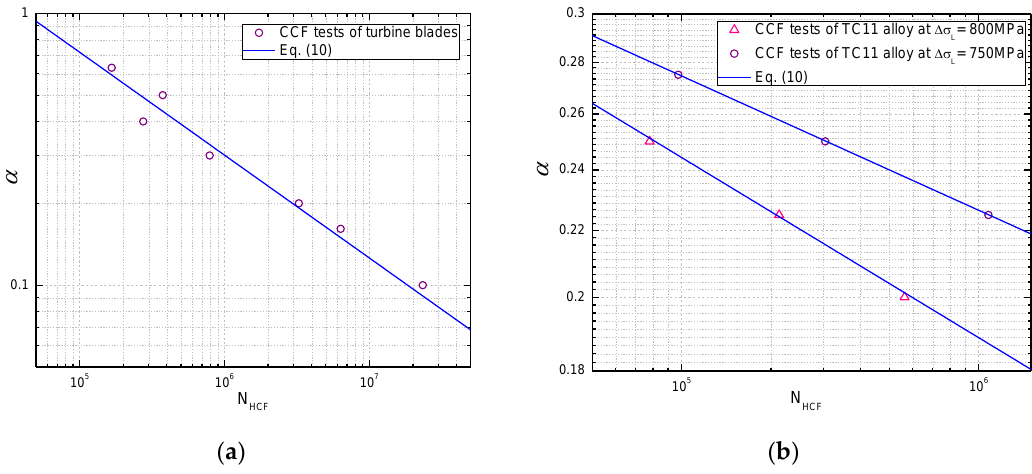
Figure 4. Fitted curves between 𝛼 and HCF cycles based on CCF tests of ( a ) turbine blades [42] and ( b ) TC11 alloys [32].